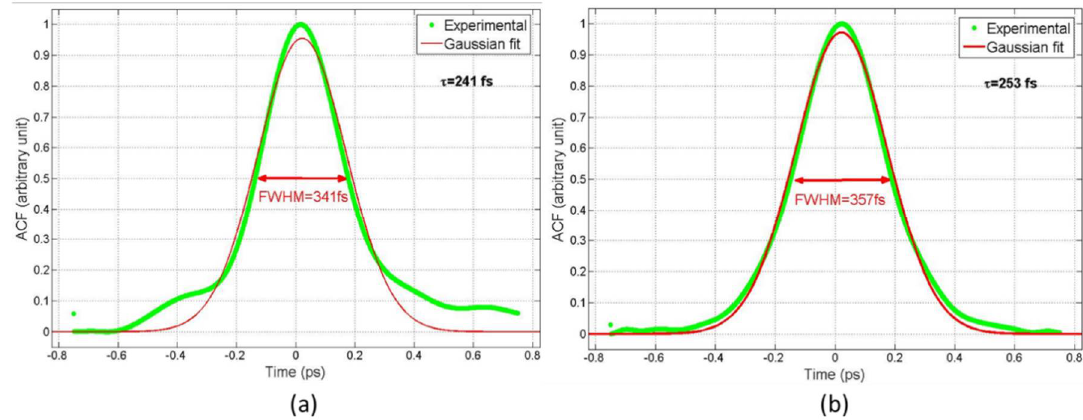
Figure 4. Autocorrelation trace of the pulsed laser sources ( a ) Ti:Sa and ( b ) OPO, respectively. Results of the Gaussian fit are also reported. Table 1. Pulsed laser sources properties.